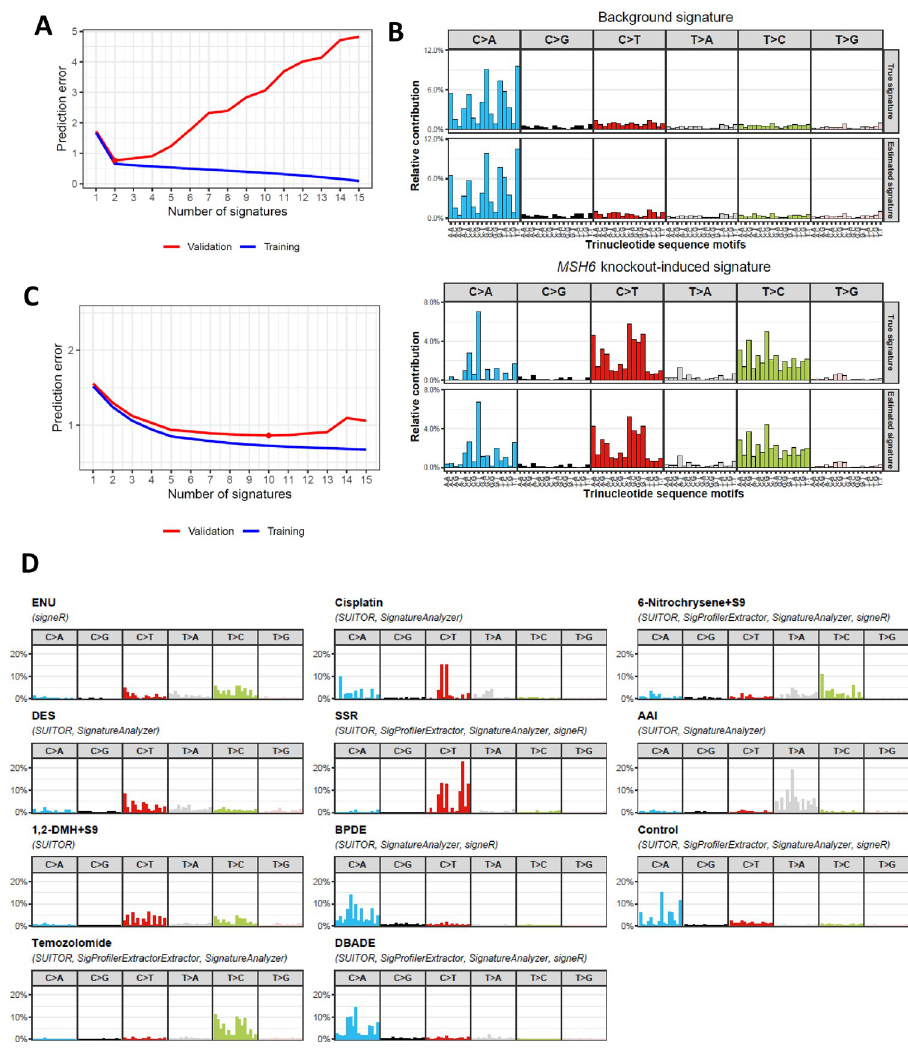
Fig 2. In vitro evaluation of SUITOR and other methods. a) Prediction errors of SUITOR for the training and validation sets of in vitro knockout study of DNA repair gene MSH6 . The red dot denotes the number of signatures with the minimal prediction error in the validation set. b) Profiles of single base substitution signature estimated by SUITOR in MSH6 gene knockout study. The x-axis indicates the 5’ and 3’ nucleotides for each substitution type (e.g., T [C > A]C, cytosine to adenine substitution with 5’ thymine and 3’ cytosine). The top panel: the true and estimated background signatures (cosine similarity = 0.991; cosine similarity = 1 suggests two profiles being identical.); the bottom panel: the true and estimated MSH6 knockout-induced signatures (cosine similarity = 0.997). c) Prediction errors by SUITOR for the training and validation sets of in vitro study of environmental or therapeutic mutagens. The red dot indicates the minimal prediction error in the validation set achieved by ten signatures, including one background signature and nine mutagen-induced signatures. d) Signatures discovered from the in vitro study of environmental or therapeutic mutagens by four methods. Methods which could identify a given mutagen are enclosed in parentheses. ENU: N-ethyl-N-nitrosourea; 6-Nitrochrysene+S9: 6-Nitrochrysene mixed with S9 rodent liver- derived metabolic enzyme; DES: diethyl sulfate; SSR: simulated solar radiation; AAI: aristolochic acid I; 1,2-DMH+S9: 1,2-dimethylhydrazine mixed with S9 rodent liver-derived metabolic enzyme; BPDE: